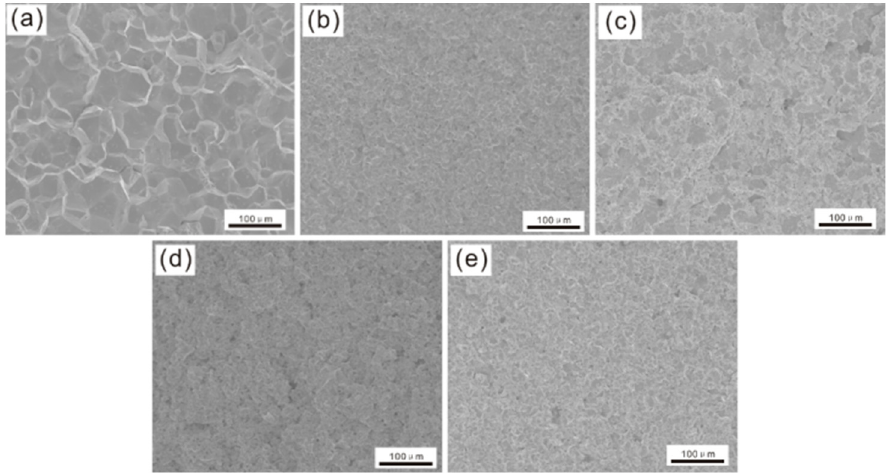
Figure 9. Flexural fracture morphology of tantalum tungsten composite with different tungsten contents( a ) Pure Ta, ( b ) Ta-2.5 wt%W, ( c ) Ta-5 wt%W, ( d ) Ta-7.5 wt%W, ( e ) Ta-10 wt%W.